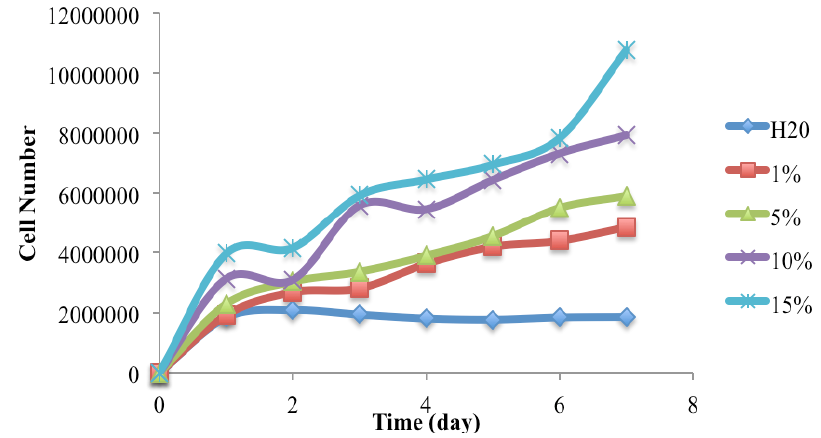
Figure 2. Growth curves of C. vulgaris in DI water with MxG juice at room temperature and 600 μmol m − 2 s − 1 light intensity.